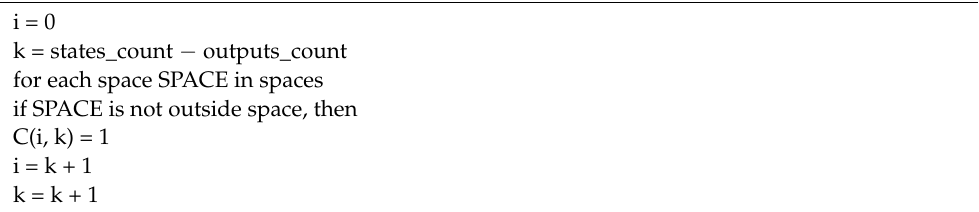
Algorithm 7. The definition of structure of the output matrix C (pseudo-code